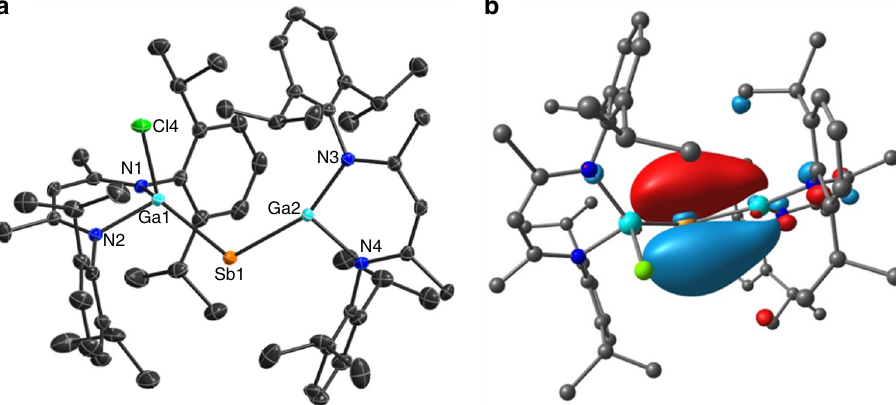
Fig. 7 Molecular and geometry optimized structures of 5 and 5 ′ . ( a ) Molecular structure of 5 . H-atoms were omitted for clarity, displacement ellipsoids are drawn at the 50% probability level. b Geometry optimized structure of 5 ′ , with the HOMO plotted. Selected bond lengths and angles: 5 , Ga – Sb 2.5528(2), 2.4629(2)Å, Ga – Sb – Ga 113.184(7)°; 5 ′ , Ga – Sb 2.639, 2.535Å, Ga – Sb – Ga